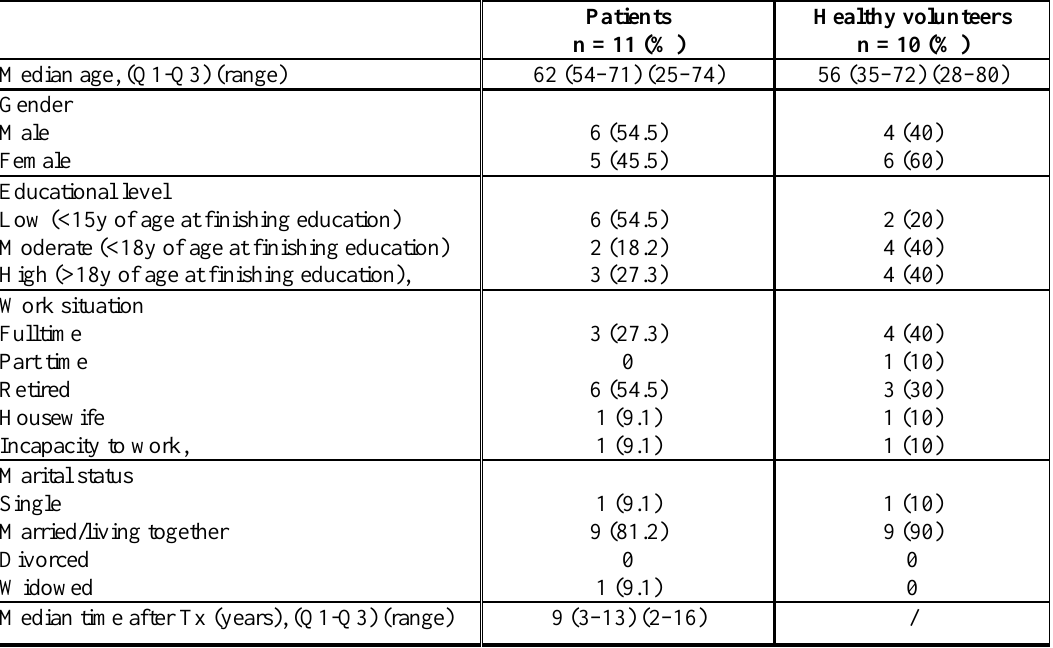
Table 1. Demographic characteristics of the